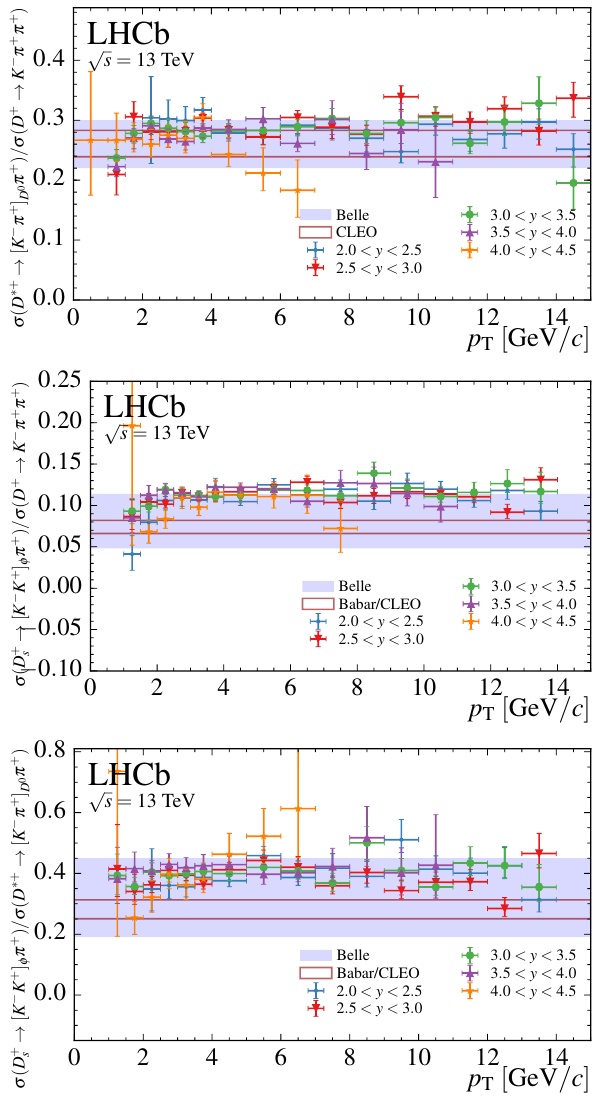
Figure 10. Ratios of cross-section-times-branching-fraction measurements of (top) D (cid:3) + , and (mid- dle) D + mesons with respect to D + cross-sections, and (bottom) D + over D (cid:3) + mesons. The s s bands indicate the corresponding ratios computed using measurements from e + e (cid:0) collider exper- iments [39{41]. The ratios are given as a function of p T and di(cid:11)erent symbols indicate di(cid:11)erent ranges in y . The notation (cid:27) ( D f ) is shorthand for (cid:27) ( D ) ( D f ). ! (cid:2) B ! { 16